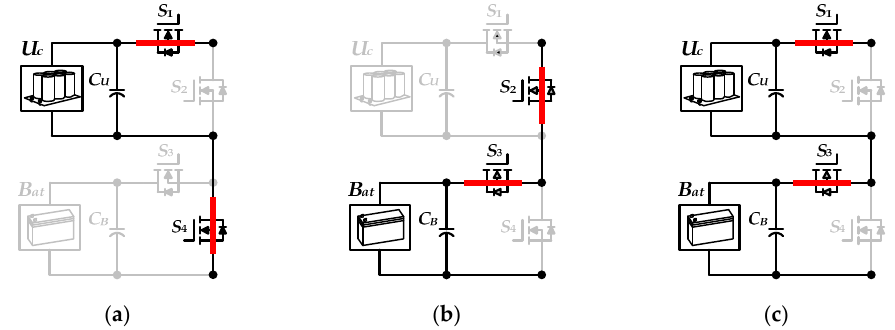
Figure 4. Equivalent circuits of the multiport switch under different operating modes. ( a ) UC charge mode or discharge mode. ( b ) Battery charge mode or discharge mode. ( c ) Battery/UC dual-energy in series discharge mode.